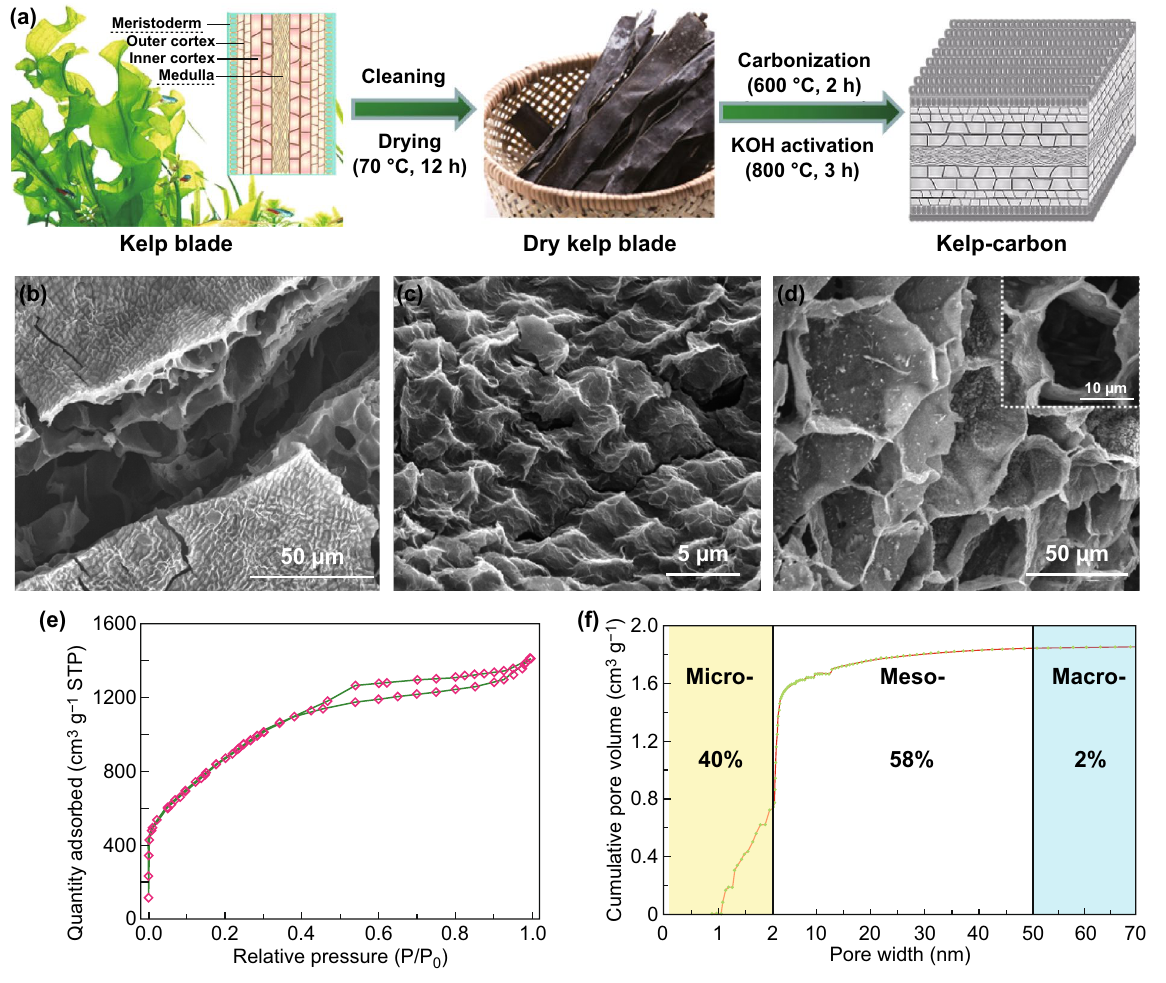
Fig. 2 a Main preparation process of kelp-carbon, including graphical illustrations on the microstructure of kelp blade and 3D hierarchical architecture of kelp-carbon. SEM images of the kelp-carbon: b overall morphology, c surface morphology, and d interior morphology. e N 2 adsorption/desorption isotherm and f 2D-NLDFT pore size distribution of the